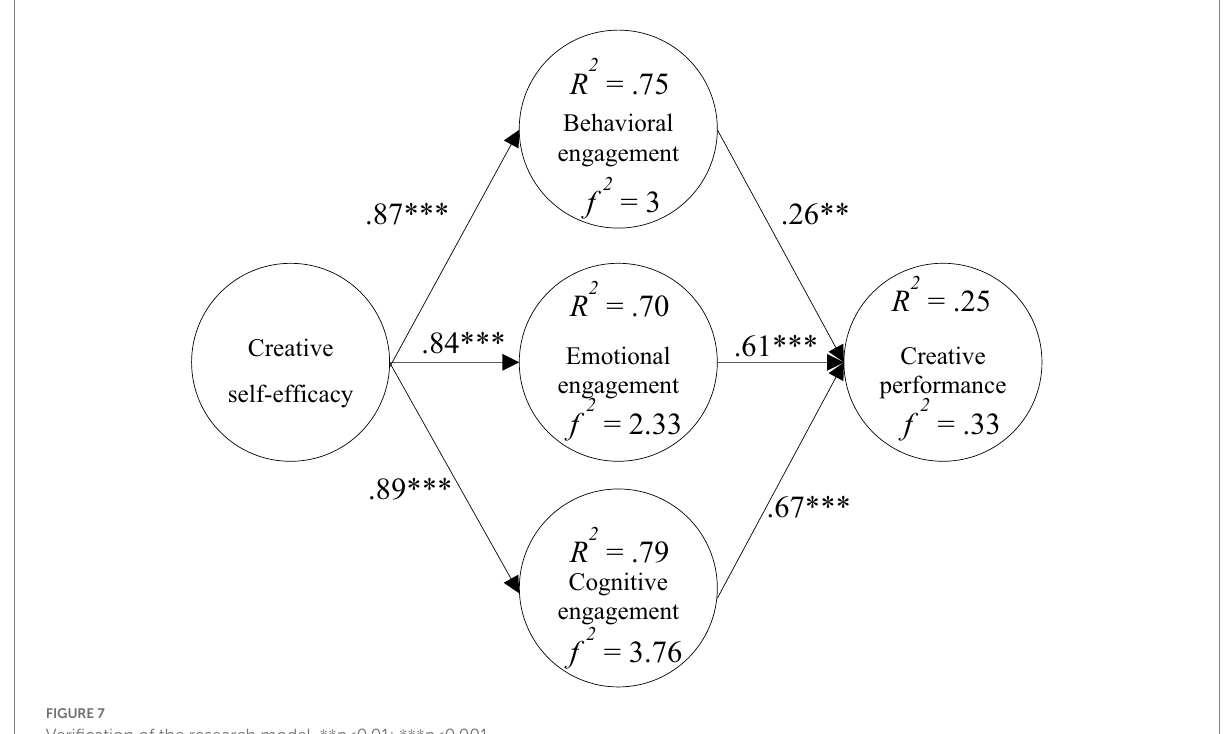
FIGURE 7 Verification of the research model. ** p < 0.01; *** p <